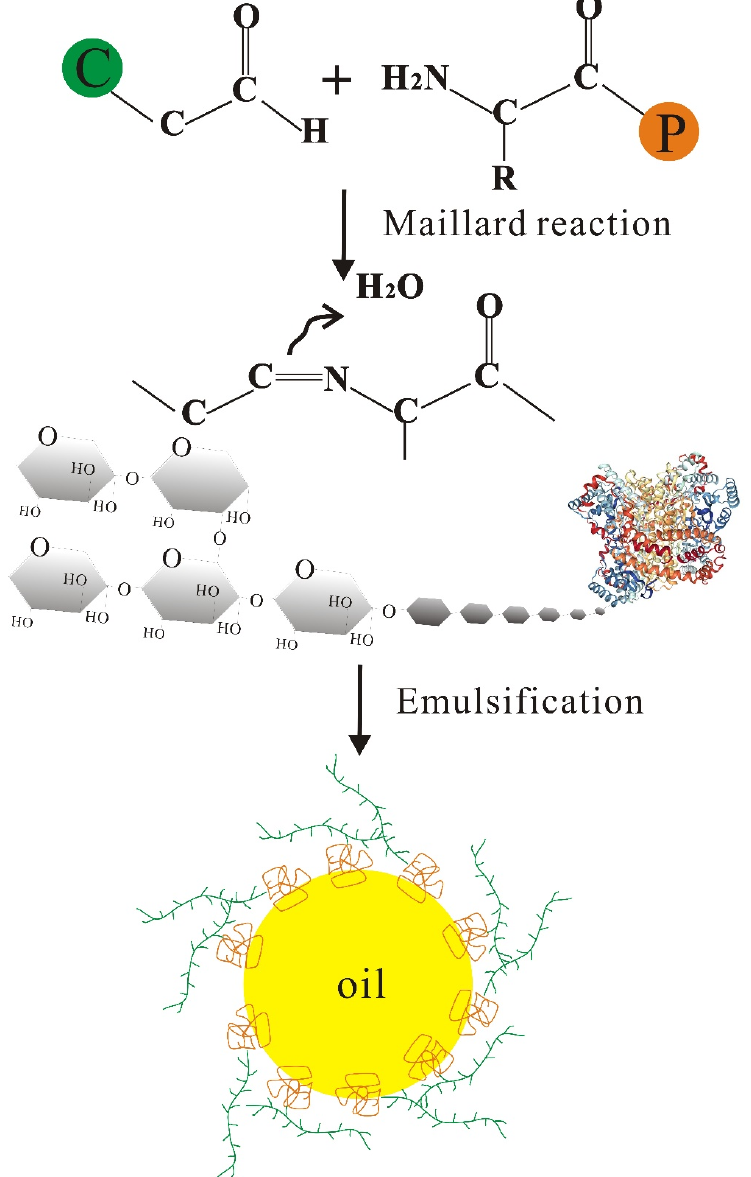
Figure 2. The schematic illustration of the formation of the soy protein–polysaccharide complex for emulsion stabilization.